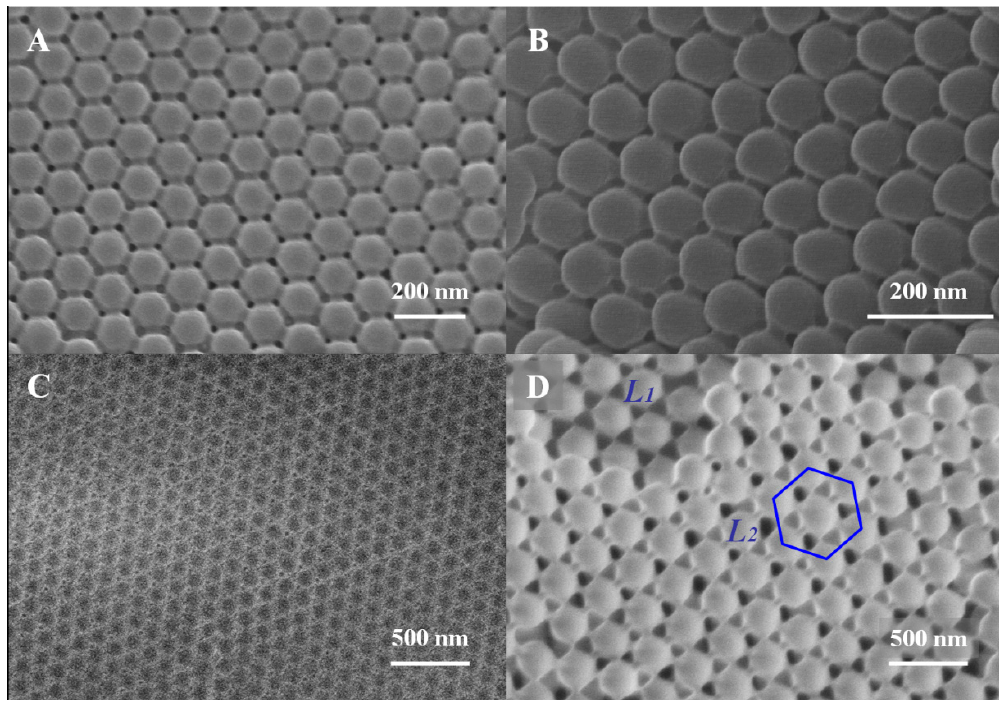
Figure 2. SEM images of PMMA self-assembled CCs: ( A ) Top view of 117-nm CC; ( B ) Cross section of 117-nm CC; ( C ) Large-scale top view of 117-nm CC; ( D ) Top view of 2-layer 200-nm CC.